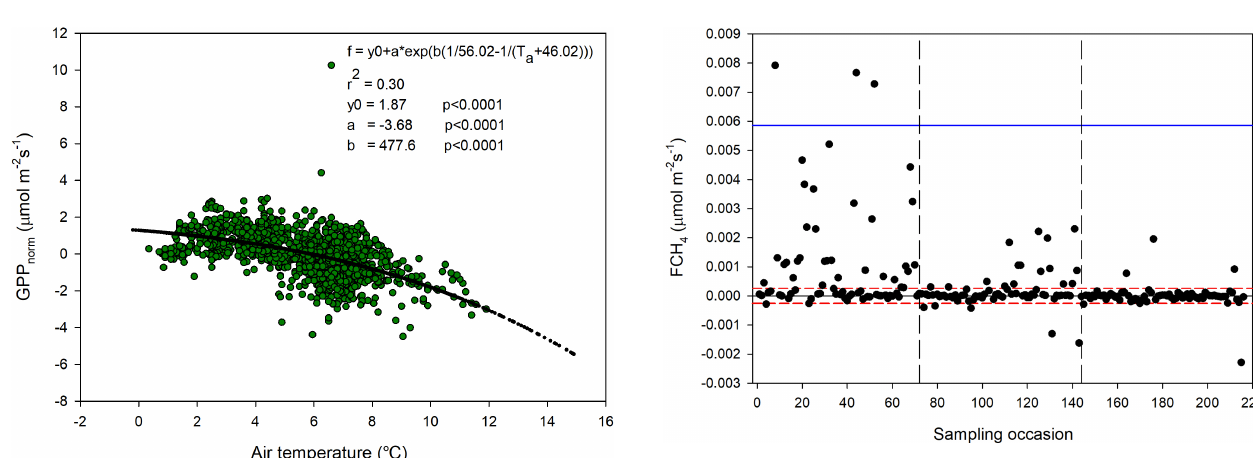
Figure 12. Measured CH 4 exchange (FCH 4 ) from the 24 sampling points using a dark chamber and portable gas analyzer. The dashed red lines indicate CH 4 flux detection limit (i.e., inside the limits of detection the exact numbers are highly uncertain), and the blue line represents 3 × SD. The dashed vertical lines are the same as in